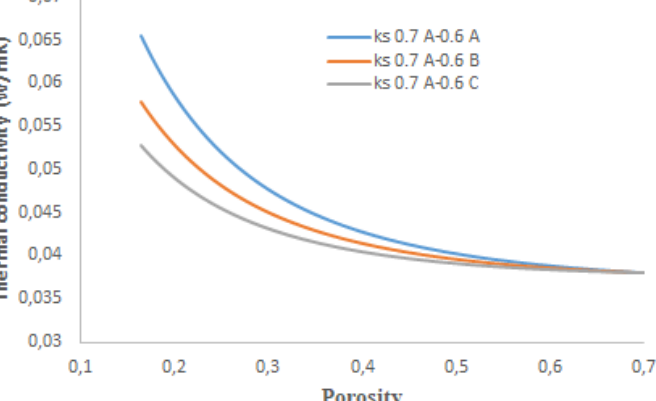
Figure 5. The effect of solid material porosity on combined thermal conductivity